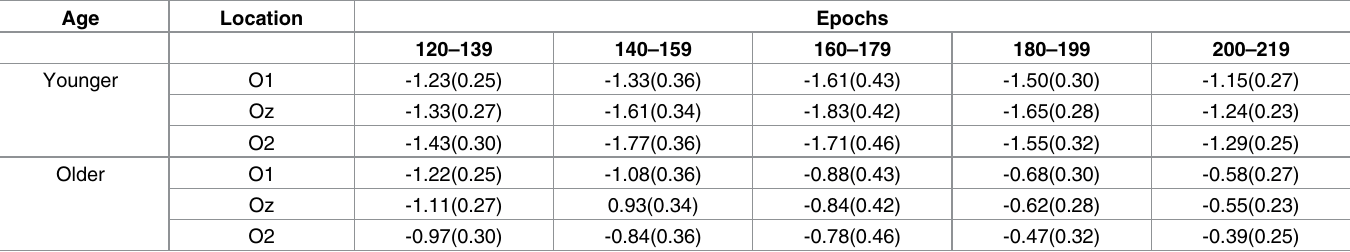
Fig 3. A. ERPs to StandardAppearance,Deviant Appearance and the Deviant minus Standarddifference potentialsin Younger and Older Group. B: Differencepotentials in the two age groups. https://doi.org/10.1371/journal.pone.0188929.g003 ranges. Results of the ANOVAs confirmed this observation. As for the first three epochs the only significant effect appears as an Age x Location interaction in the 140–159 ms range, 2 = 0.20, ε = 0.67. According to the Tukey HSD test, in the younger F(2,56) = 7.01, p < 0.01, η p group the negativity was larger at O2 than at O1. In contrast with the earlier ranges, in the Table 1. Mean amplitudes of the vMMN in the five consecutive ranges. The values are given in microvolts. SEM is in parenthesis. (The mean amplitudes of every participantare listed in S1